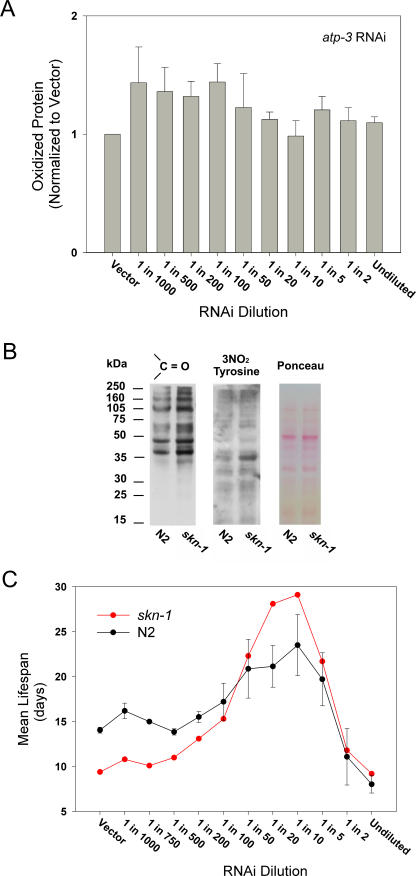
Oxidative Stress Does Not Correlate with atp-3 Life Extension(A) Whole-worm extracts were prepared from an atp-3 RNAi dilution series established in N2 exactly as described for Figure 3A (and including 1:1,000, 1:500, and 1:200 dilutions [atp-3 RNAi to empty vector]). Protein carbonylation was detected using DNP chemistry coupled with western analysis. Data are presented as the mean (± SEM) of replicate experiments from a dilution series sample set normalized to vector-only treatment (following Ponceau normalization to control for differences in sample loading).(B) N2 animals were exposed to either vector or skn-1 RNAi from the time of hatching. Levels of protein carbonylation in whole-worm, L1 extracts were detected using DNP chemistry coupled with western analysis (left panel). Samples were reprobed for 3-nitrotyrosine staining (middle panel). Equal protein loading was confirmed by Ponceau staining (right panel). A duplicate experiment showed identical results.(C) An RNAi dilution series against atp-3 was established in both wild-type (N2, black line) and mutant skn-1(zu67) (red line) animals (n = 80/condition). skn-1 animals were collected from 16,000 eggs as described in Materials and Methods.